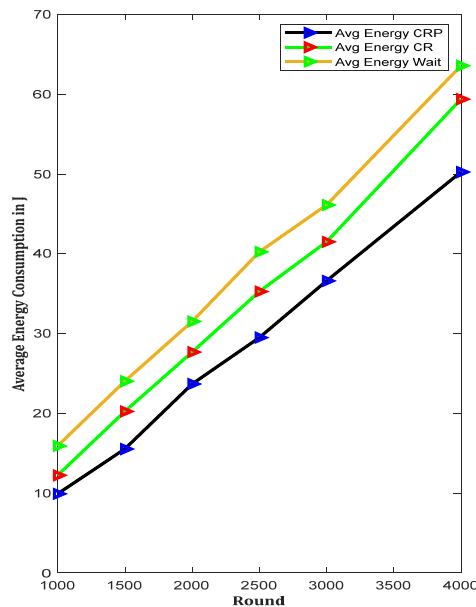
Figure 9. Energy consumption of nodes vs. round.